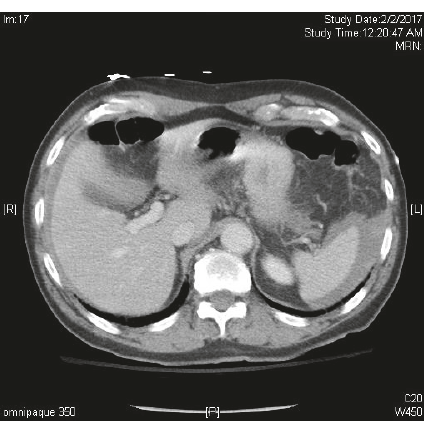
Figure 1: Horizontal CT scan demonstrating hemoperitoneum from iatrogenic spleen injury.